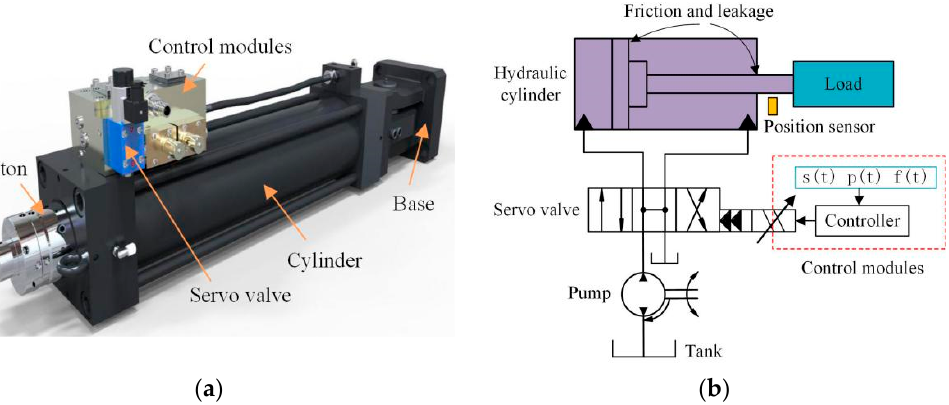
Figure 1. A hydraulic servo control system: ( a ) an actual diagram of servo-hydraulic cylinder; ( b ) working principle diagram of the servo-hydraulic cylinder.